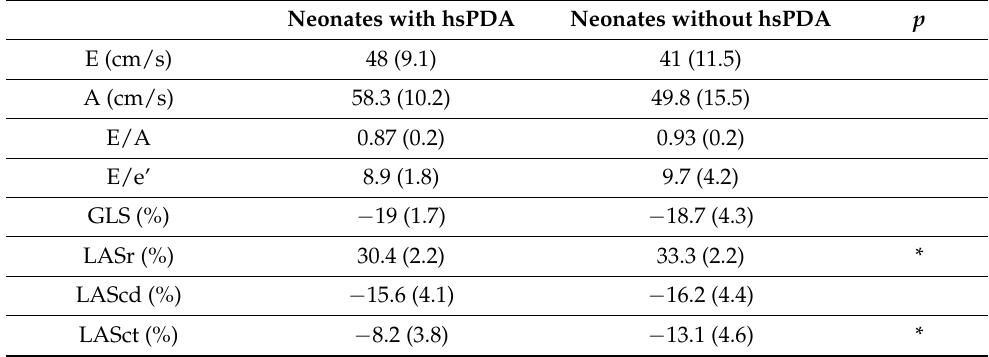
Table 8. Comparison of echocardiographic parameters in preterm neonates with and without